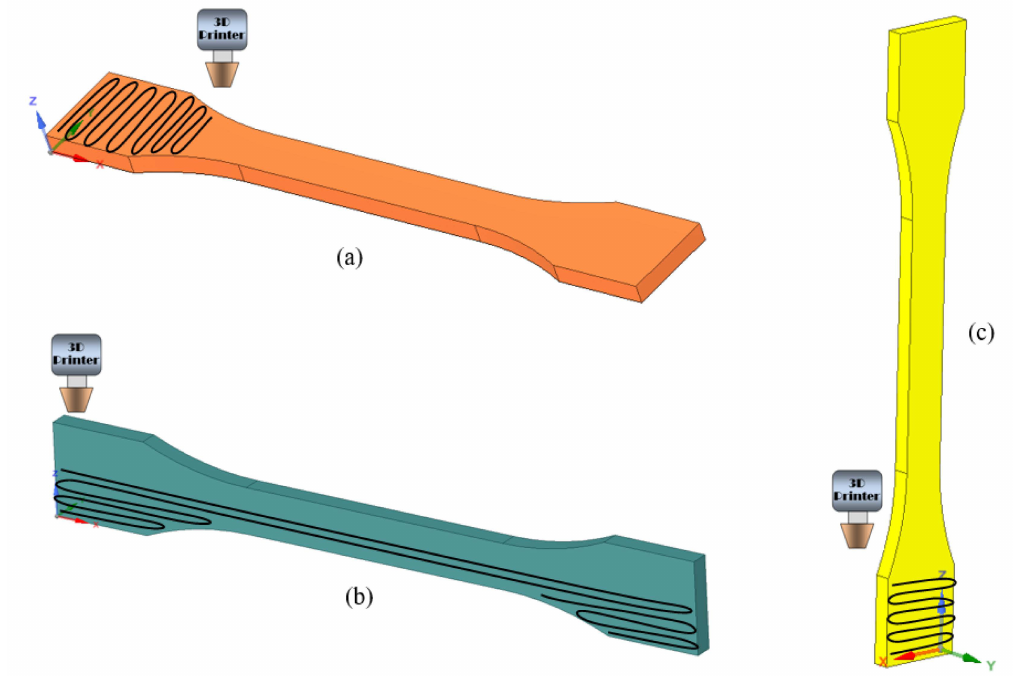
Figure 4. Tensile specimens printing directions: ( a ) XY-Specimen (printed flatwise); ( b ) XZ1-Specimen (printed sidewise); ( c ) XZ2-Specimen (printed